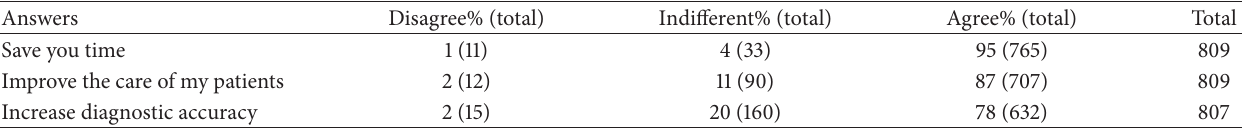
Table 3: Perceptions of medical app use amongst US medical students ( 𝑁 = 731